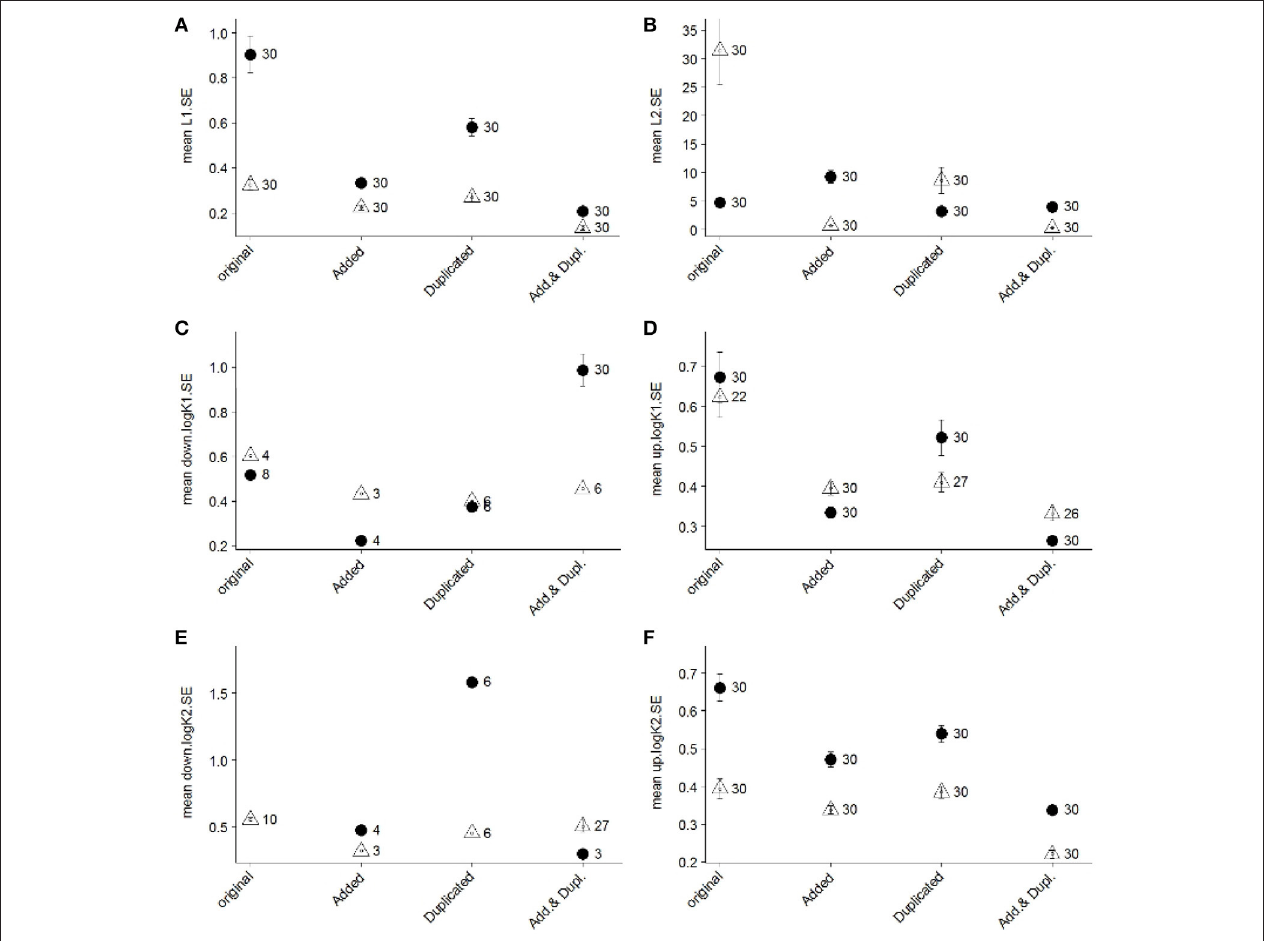
FIGURE 5 | Mean standard error (SE) values of estimated ligand concentrations (“L 1, ” A ; “L 2, ” B ) and log conditional stability constants (“log K 1, ” C,D ; “log K 2, ” E,F ) of 30 repeated analyses using the Gerringa et al. (2014) non-linear fit for two ligand classes on titrations of two different samples from the GA03 occupation of the BATS site (2m sample, closed circles; 96m sample, open triangles). Two SE values were calculated for conditional stability constants (“up,” panels D,F ; “down,” panels C,E ) since the SE of the log values are not symmetrical (Gerringa et al., 2014). The “original” SE results represent the outcome of the interpretation using the original titration data. The influence of increasing the number of DFe additions (“Added”), duplicating measurements of original titration points (“Duplicated”), and both increasing the number of DFe additions and duplicating the measurements (“Add. & Dupl.”) was investigated in terms of standard errors of the data interpretation results. This was accomplished by artificially augmenting the original titration data with new DFe additions of 0.1, 0.35, 0.6, 2, 6, and 8.5 nM and duplicating these results following the error structure of the observed duplicates in the June 2010 titration data. The number noted next to each symbol represents the number of successful analyses out of the 30 attempted that resulted in a reportable value for